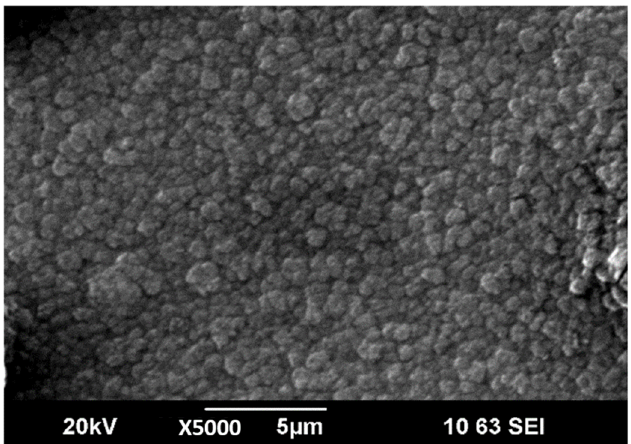
Figure 4. SEM image of surface of LiPON thin-film. Diffractograms of LiPON films deposited at 200 ◦ C for 2 h, not annealed (1)